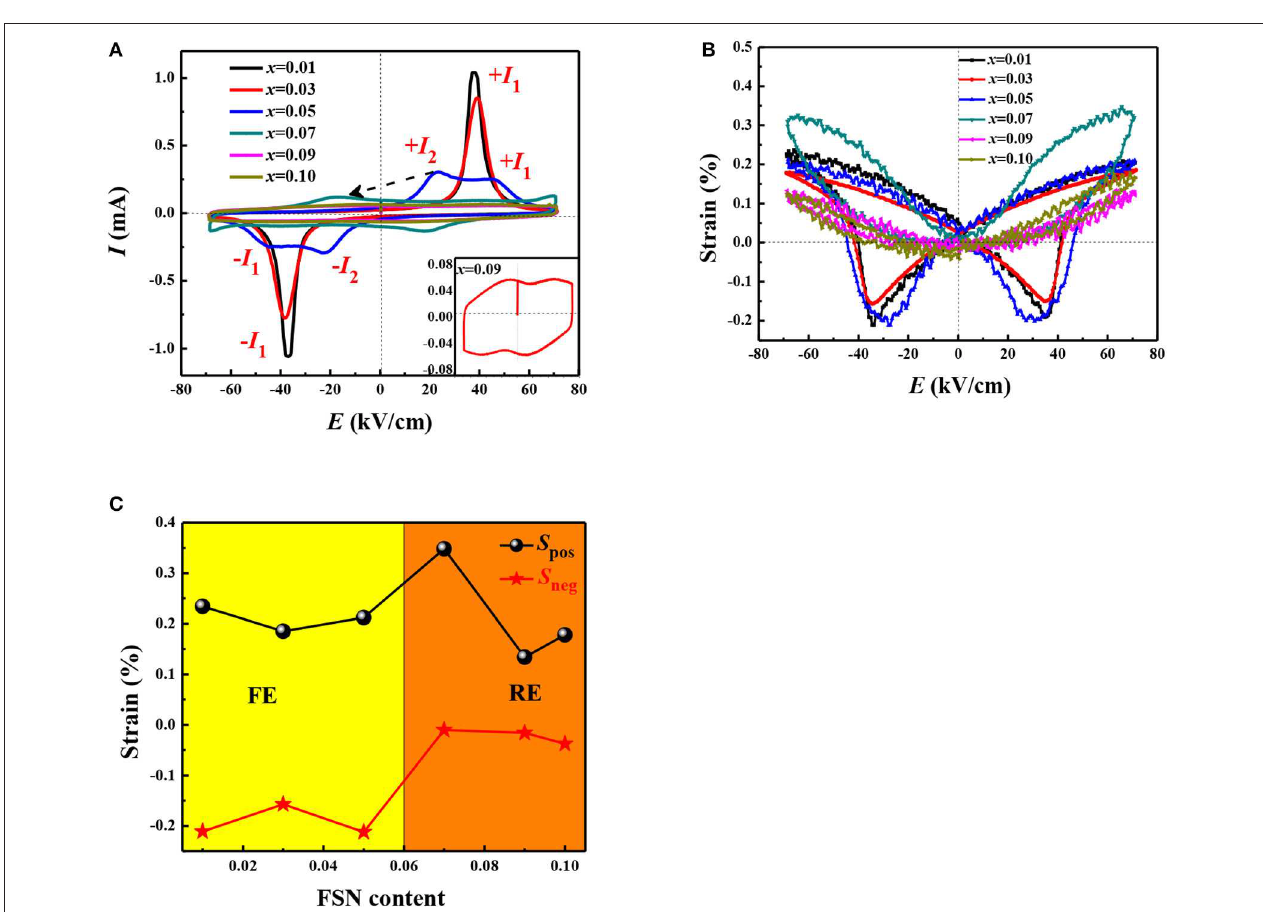
FIGURE 5 | (A) I - E loops, (B) Bipolar strain loops and (C) Positive strain ( S pos ) and negative strain ( S neg ) of BNKT- x FSN ceramics at70kV/cm.